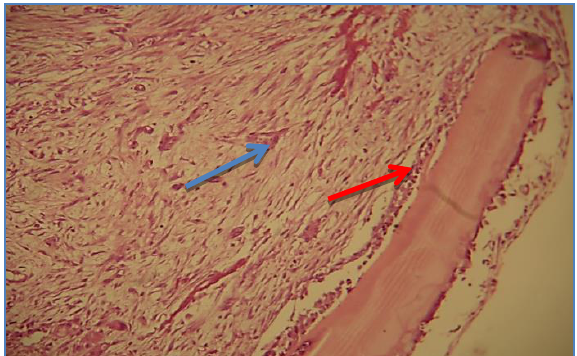
Figure, 8: Stomach of rabbit (G2),7th day p.o., showing proliferation of granulation tissue in the subserosal layer and extend in between myofibers (blue arrow) with presence remnant of suture materials in the subserosa surrounded by few inflammatory cells (red arrow) (H and